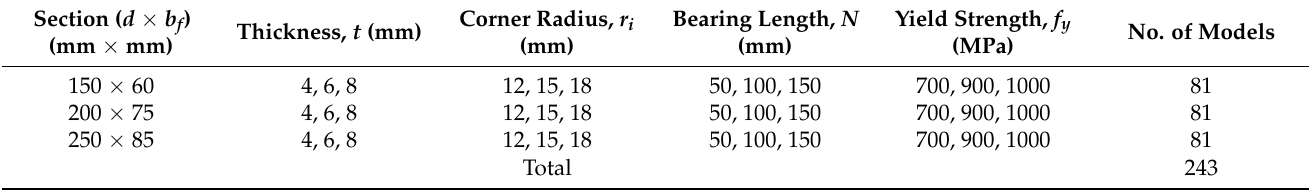
Table 5. Summary of key parameters considered.